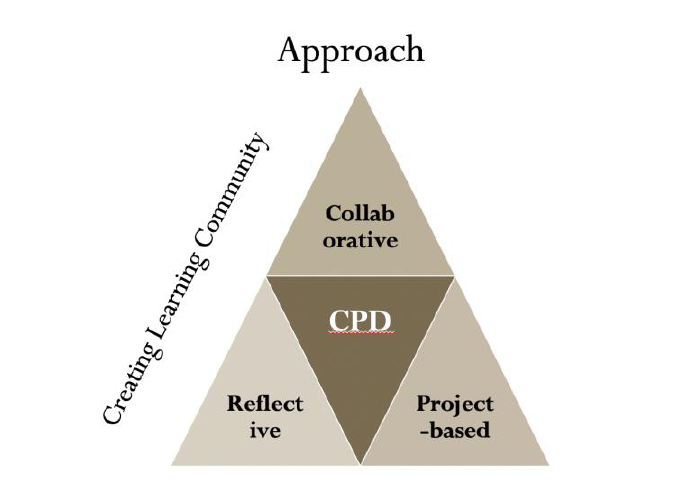
Figure 1: Approach to Online Literacy Coaching Program